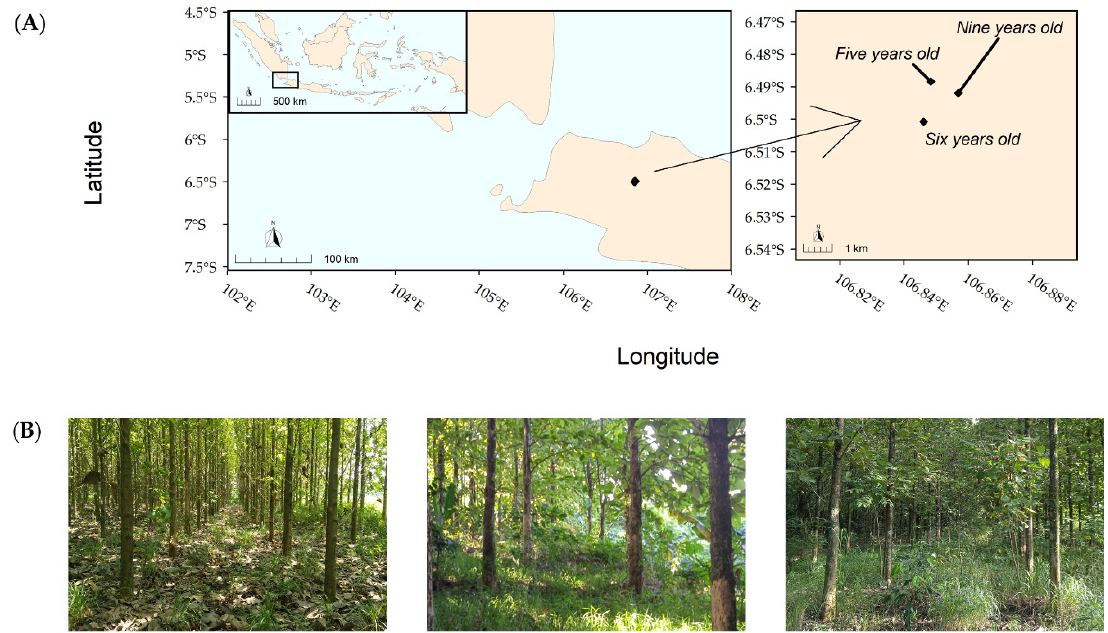
Figure 1. ( A ) Plantation locations in Cibinong, West Java, Indonesia; ( B ) plantation landscapes, from left to right: five-year- old, six-year-old, and nine-year-old plantations.